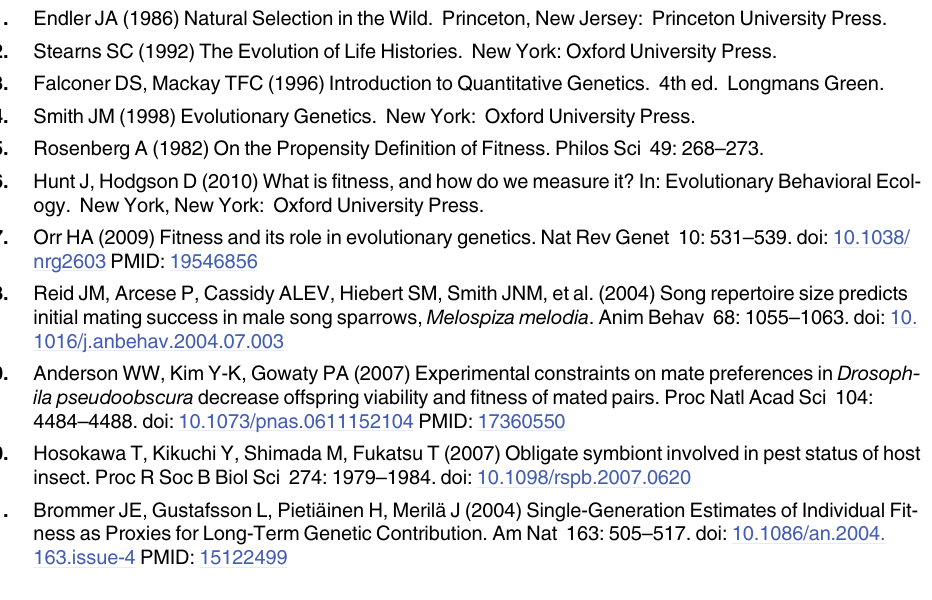
S1 Table. Offspring produced from one day of egg production by multiply-mated females. S2 Table. Offspring produced from 7 days of egg production by multiply-mated females. S3 Table. Lifetime reproductive success of multiply-mated females. S4 Table. Lifetime reproductive success of singly-mated